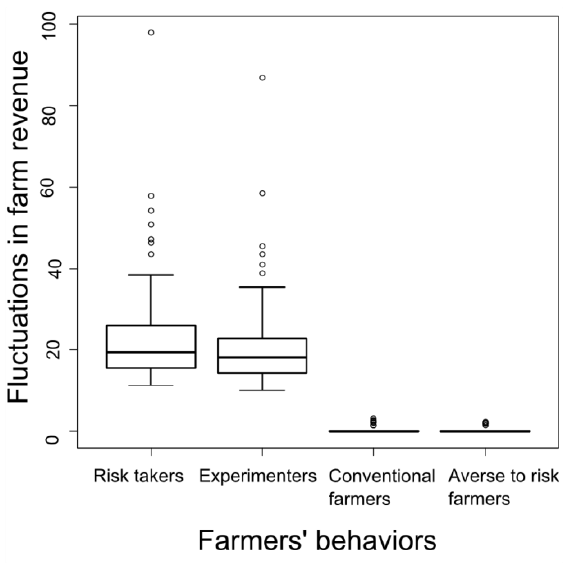
Fig. A1.3 . Fluctuations in farm revenue from the optimized model. The